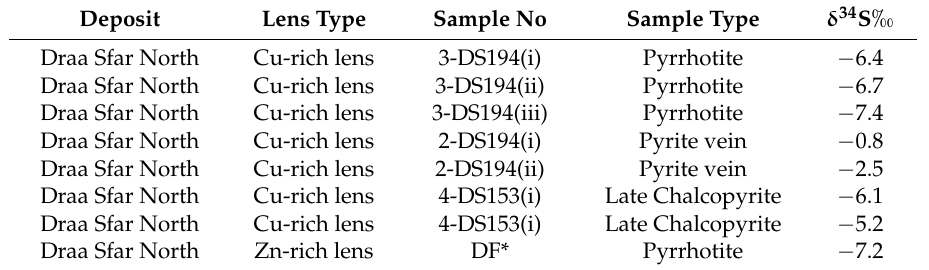
Table 2. Sulphur ( δ 34